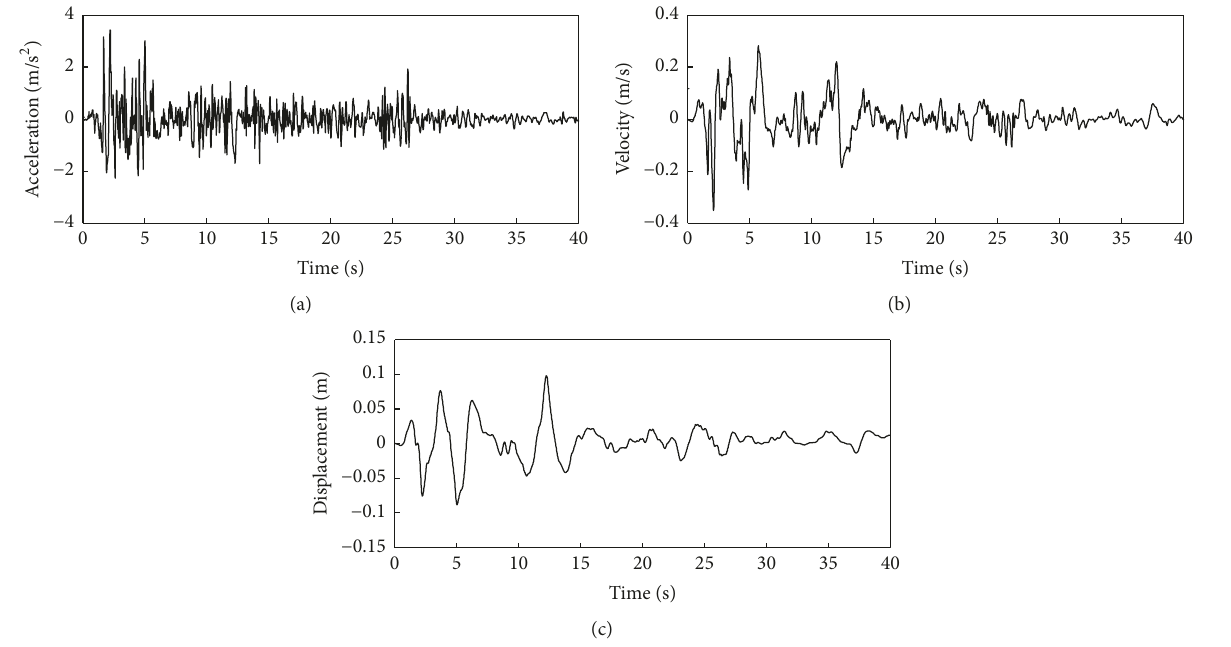
Figure 2: Simulated ground motion at station with 𝑟 𝑛 = 200 m: (a) acceleration; (b) velocity; (c) displacement.